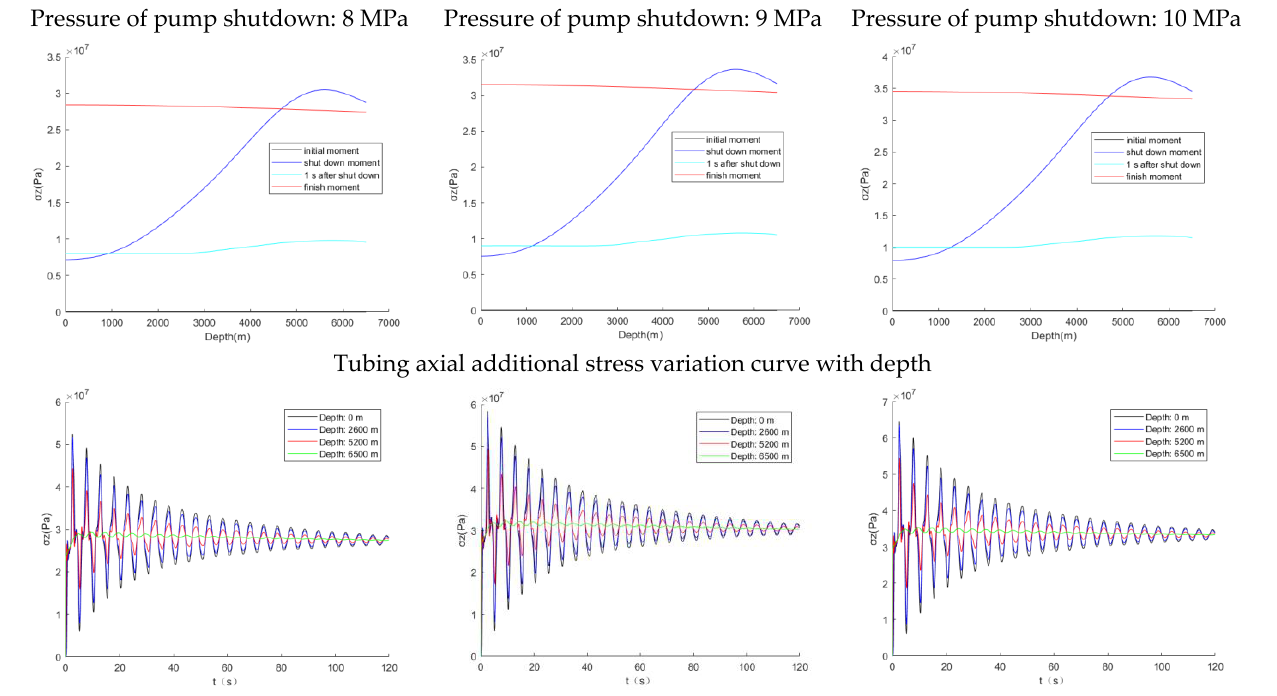
Figure 10. Variation curve of tubing axial additional stress under different initial shutdown pres- sure.